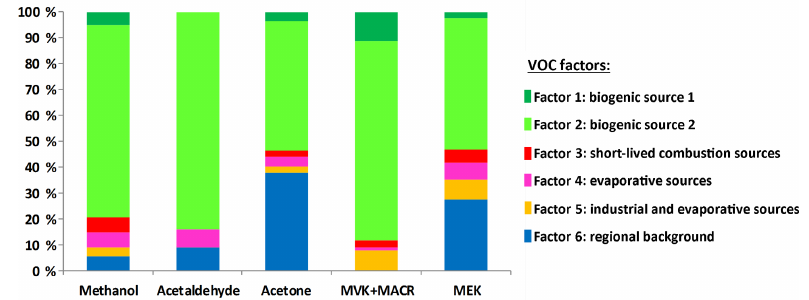
Figure 6. PMF factor contributions to the measured concentration of selected OVOCs. PMF analysis is presented in Debevec et al. (2017).